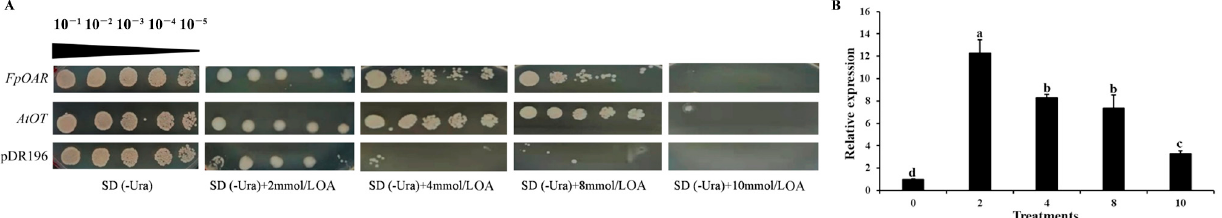
Figure 5. Growth of yeast transformants under different concentrations of oxalic acid. ( A ) Colony phenotype of yeast transformants under different concentrations of oxalic acid for 4 days. The yeast concentrations for each treatment were 10 − 1 , 10 − 2 , 10 − 3 , 10 − 4 , and 10 − 5 from left to right. ( B ) qRT-PCR analysis of AtOT under 0 (CK), 2, 4, 8, and 10 mM oxalic acid stresses in yeast cells. Different letters above the bars indicate significant differences among treatments at p < 0.05.